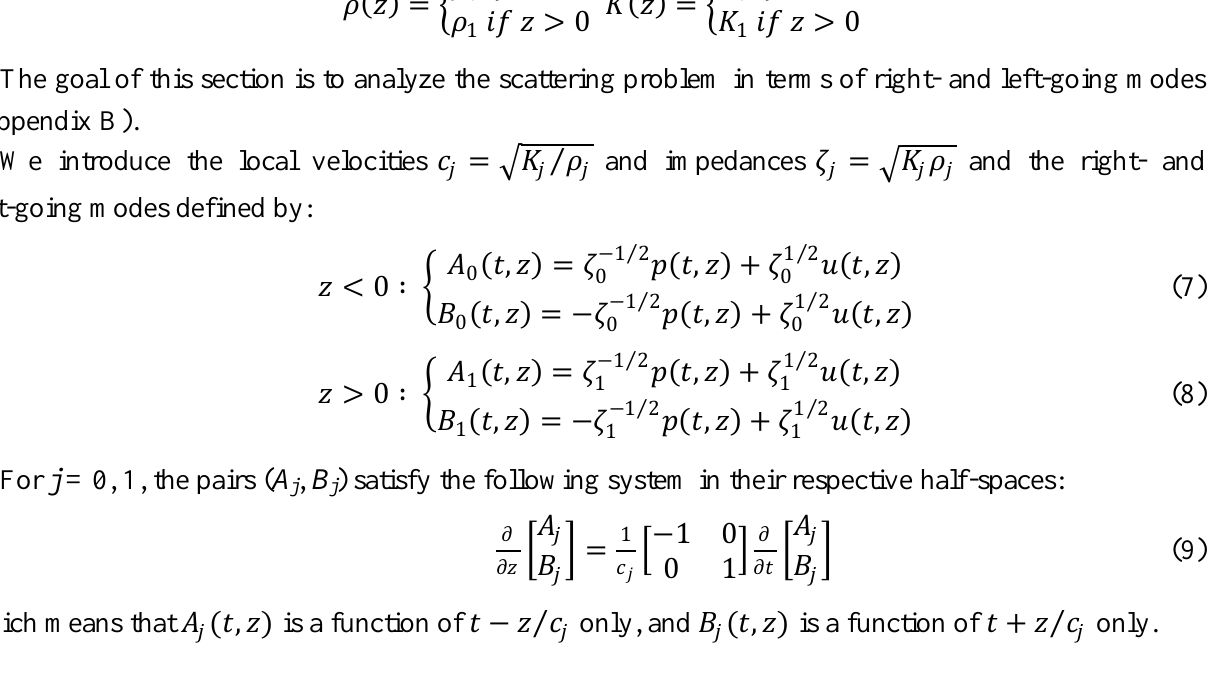
Figure 3. Scattering of a pulse by an